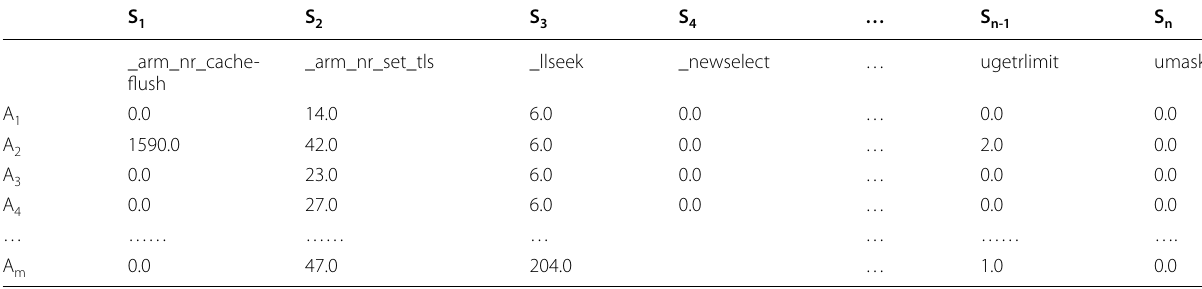
Table 2 Application samples and